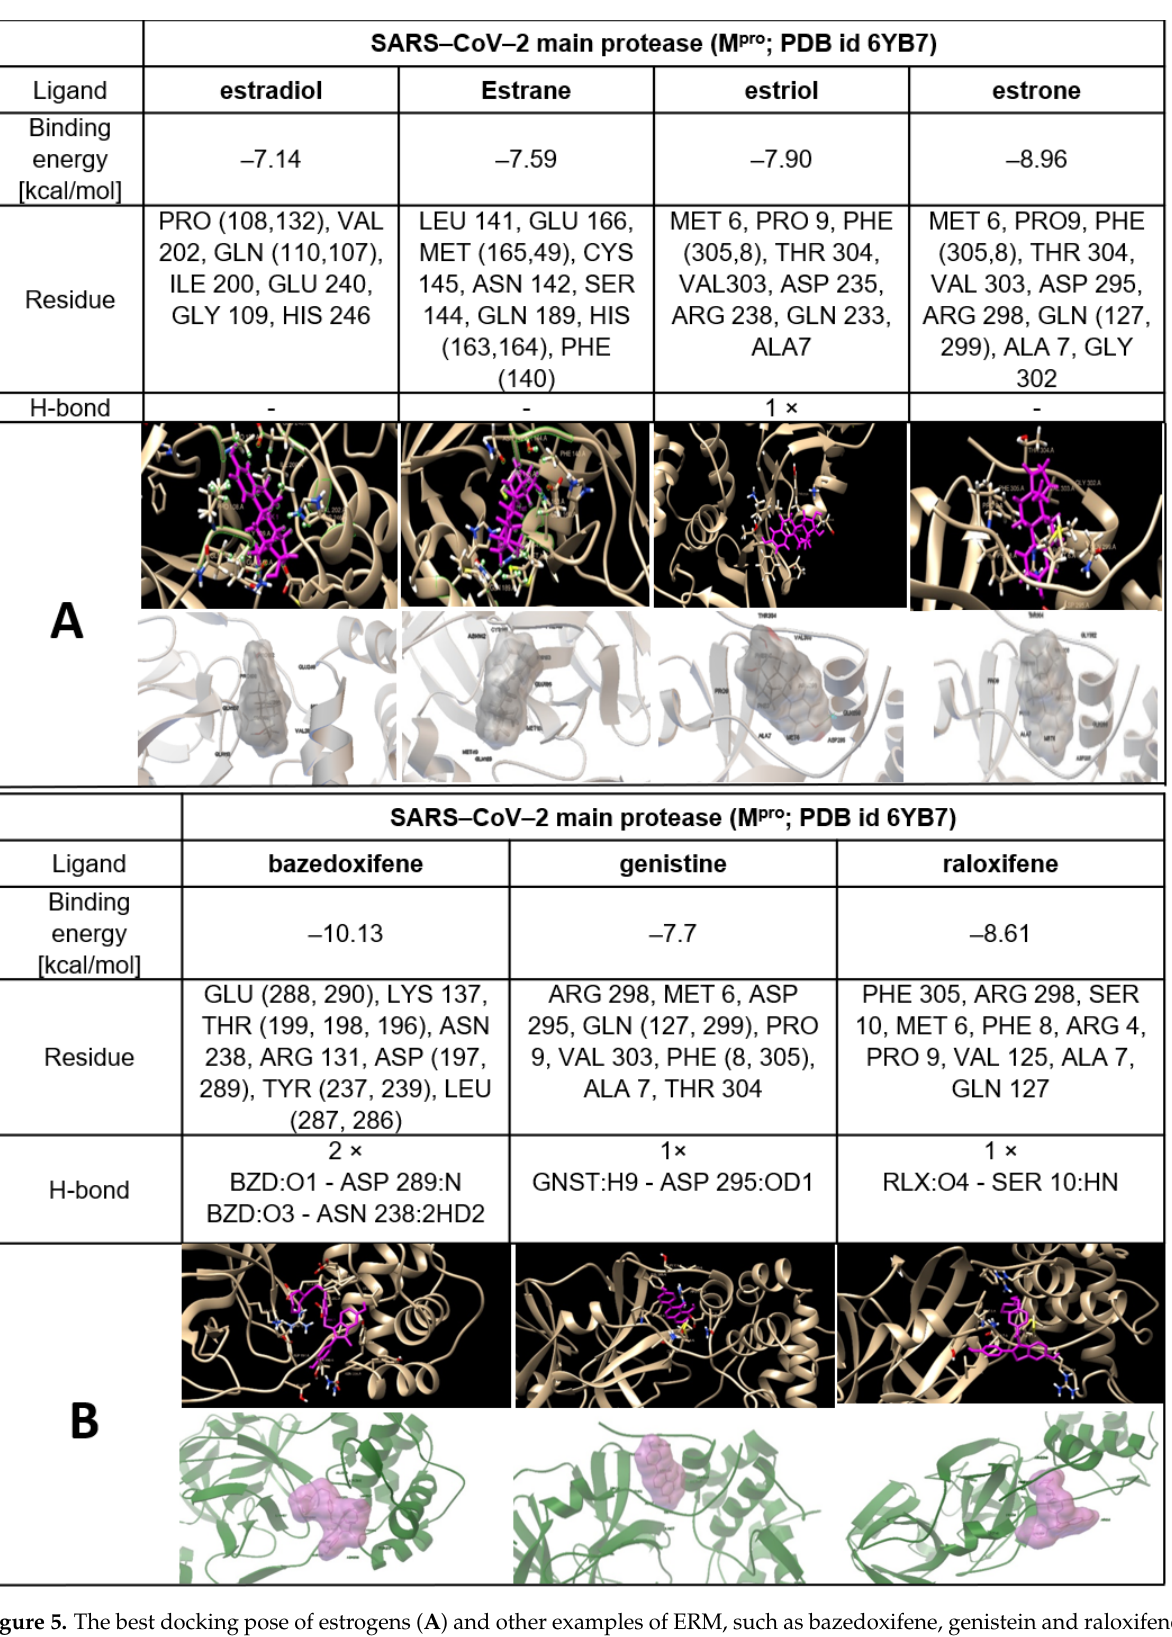
Figure 5. The best docking pose of estrogens ( A ) and other examples of ERM, such as bazedoxifene, genistein and raloxifene ( B ) to the SARS − CoV − 2 main protease structure (M pro ) with characterization of the interaction including hydrogen bonds.